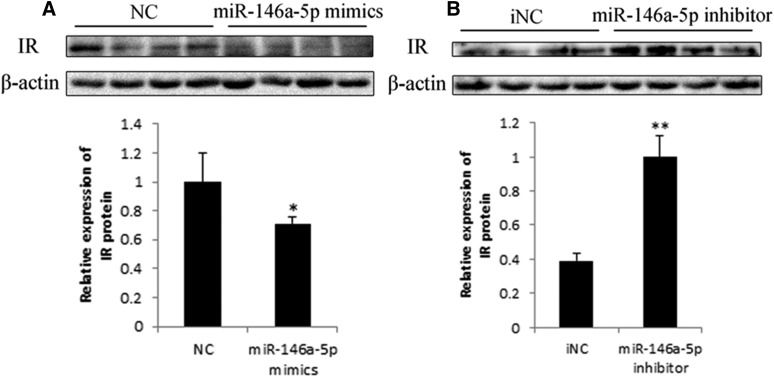
miR-146a-5p suppresses IR protein expression. Western blot and gray-scale scanning analyses of IR after transfection of miR-146a-5p mimics/NC/inhibitor/iNC (* P < 0.05, ** P < 0.01, n = 4).